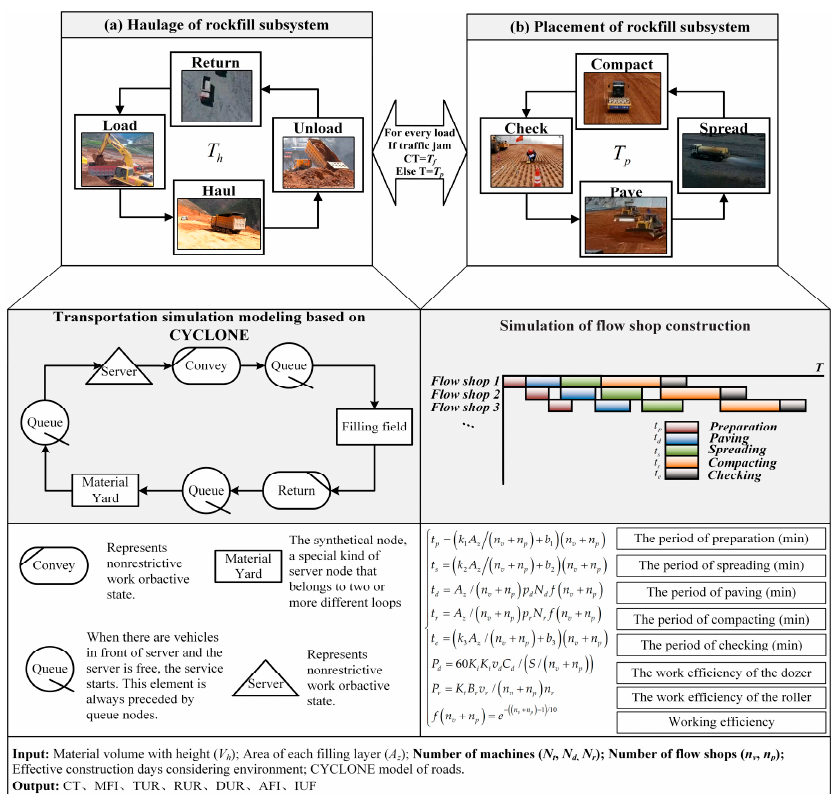
Figure 4. Principle of the improved construction simulation of high rockfill dam (CSHRD).